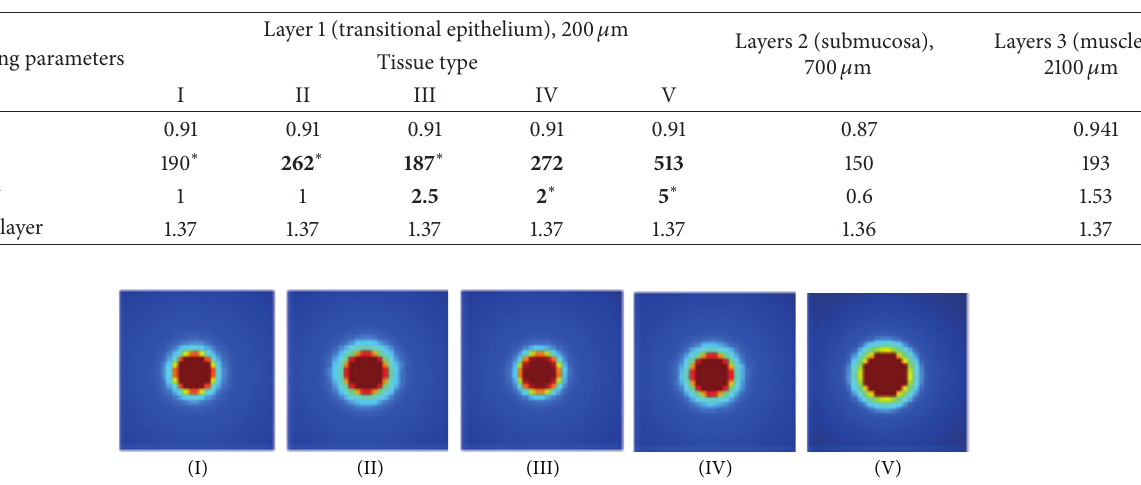
Figure 1: Processed matrices of the Monte Carlo simulated surface backscattered laser light: (I) normal, with normal size of cell nuclei, (II) enlarged nuclei, (III) absorption growth, (IV) population density augmentation, and (V) all the changes together. The size of the picture is 30 per 30 pixels.